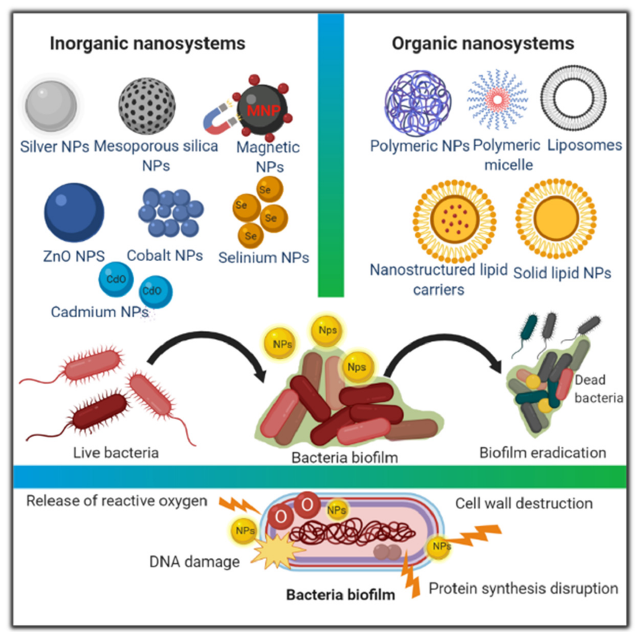
Figure 1. Graphical outline of various classes of nanosystems with illustration of their possible anti-biofilm mechanisms.